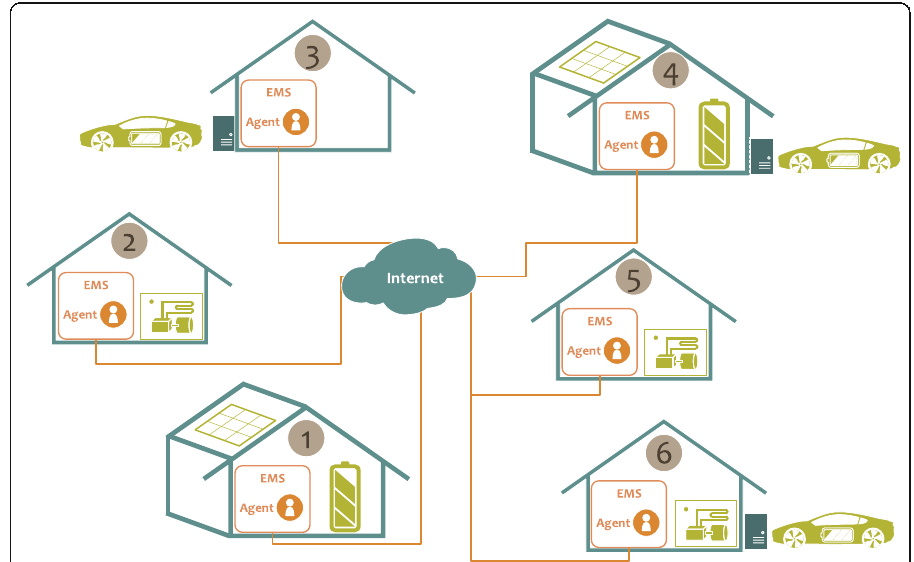
Fig. 1 Exemplary distribution of agents in a Smart